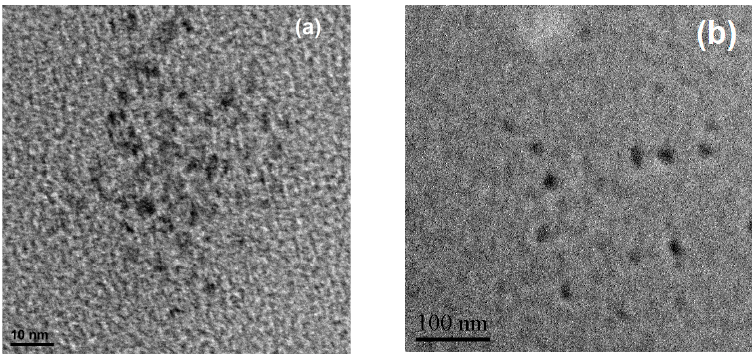
Figure 5. The TEM images of ( a ) b-SiQDs; ( b ) y-SiQDs.